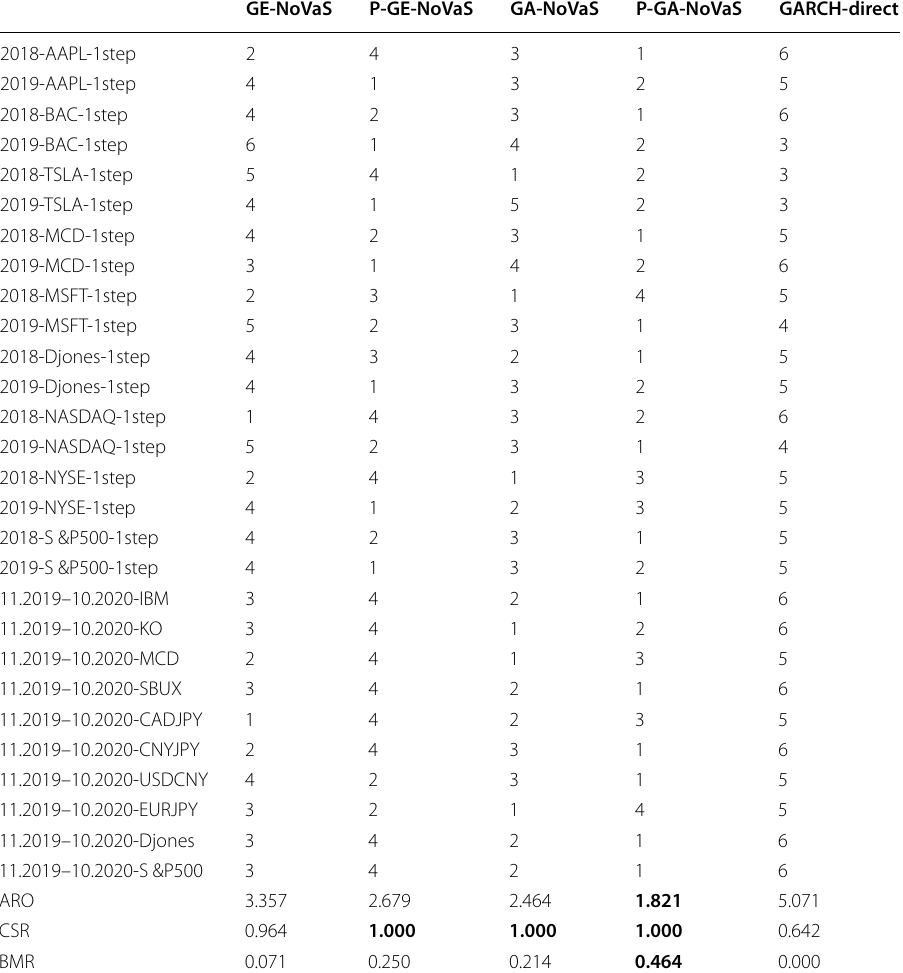
The value 6 in Table 9 means the corresponding model is eliminated from the MCS for the specific dataset. We take the bold font to mark the best results according to three